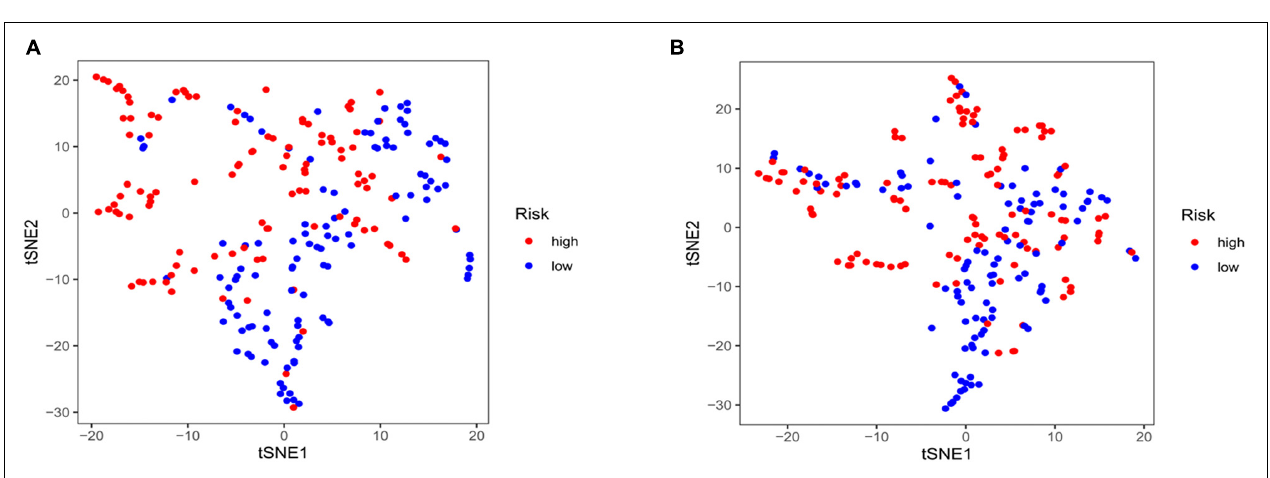
FIGURE 3 | Development and validation of prognostic ferroptosis-associated long non-coding RNA signature. (A) Kaplan–Meier curve, (B) risk score and survival status, and (C) heat map for the training group. (D) Kaplan–Meier curve, (E) risk score and survival status, and (F) heat map for the validation group.